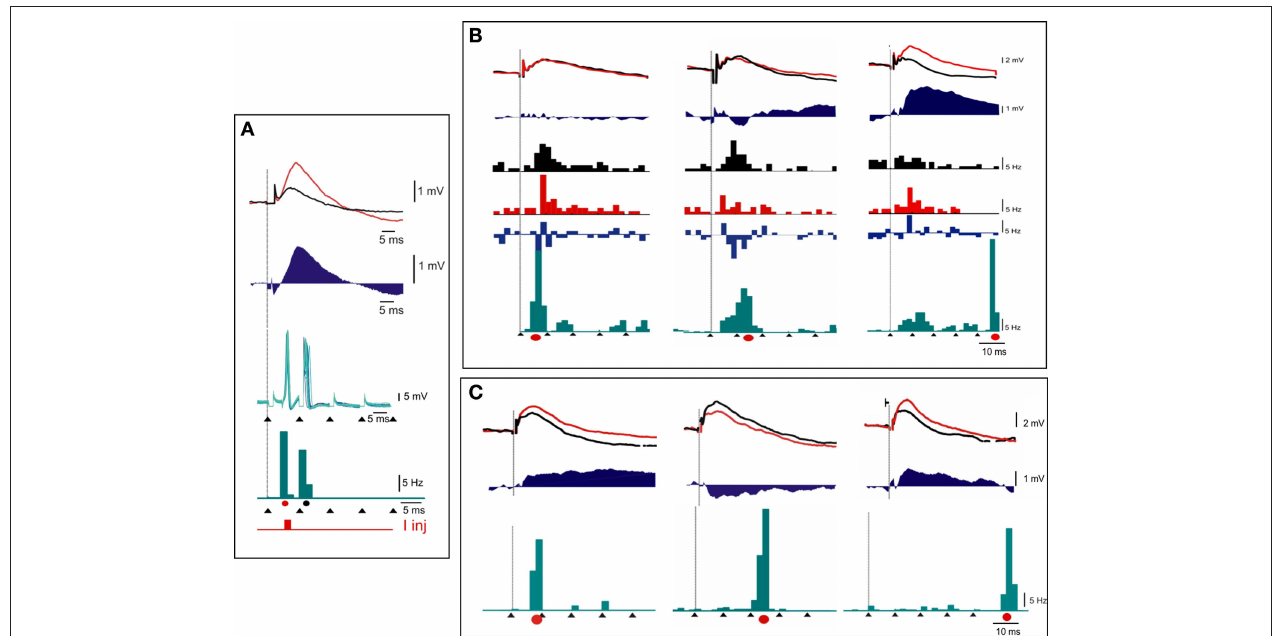
red for AFTER conditioning, and blue for difference (“AFTER”–“BEFORE”)]. The imposed spike pattern during the burst is represented below, with the same temporal scale in green, and the current pulse occurrence during S + pairing is indicated by a red dot. Note that in one of the cells (C) , the hybrid conditioning results in potentiation when the intracellular current coincides with the first shock, depression when it coincides with the third shock. Potentiation is reinstated when the current pulse coincides with the fifth shock. See text for detailed comments.